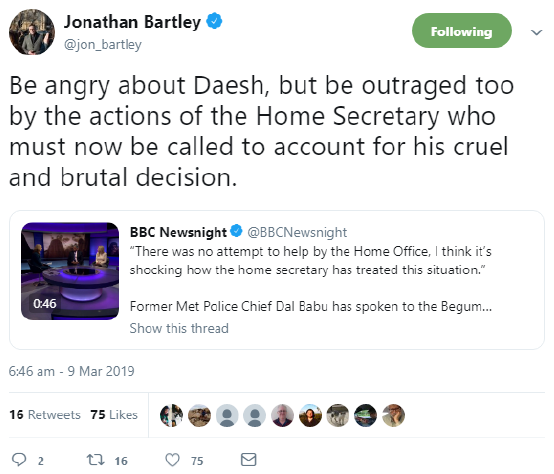
Figure 1. Tweet from Green co-leader Jonathan Bartley, 9 March 2019. The tone is fierce (‘angry . . . outraged . . . cruel . . . brutal’), and the tweet acknowl- edges both sides of the debate before focusing on condemnation of Sajid Javid. Javid is depicted as heartless and unscrupulous, with an explicit mirroring of the reader’s assumed